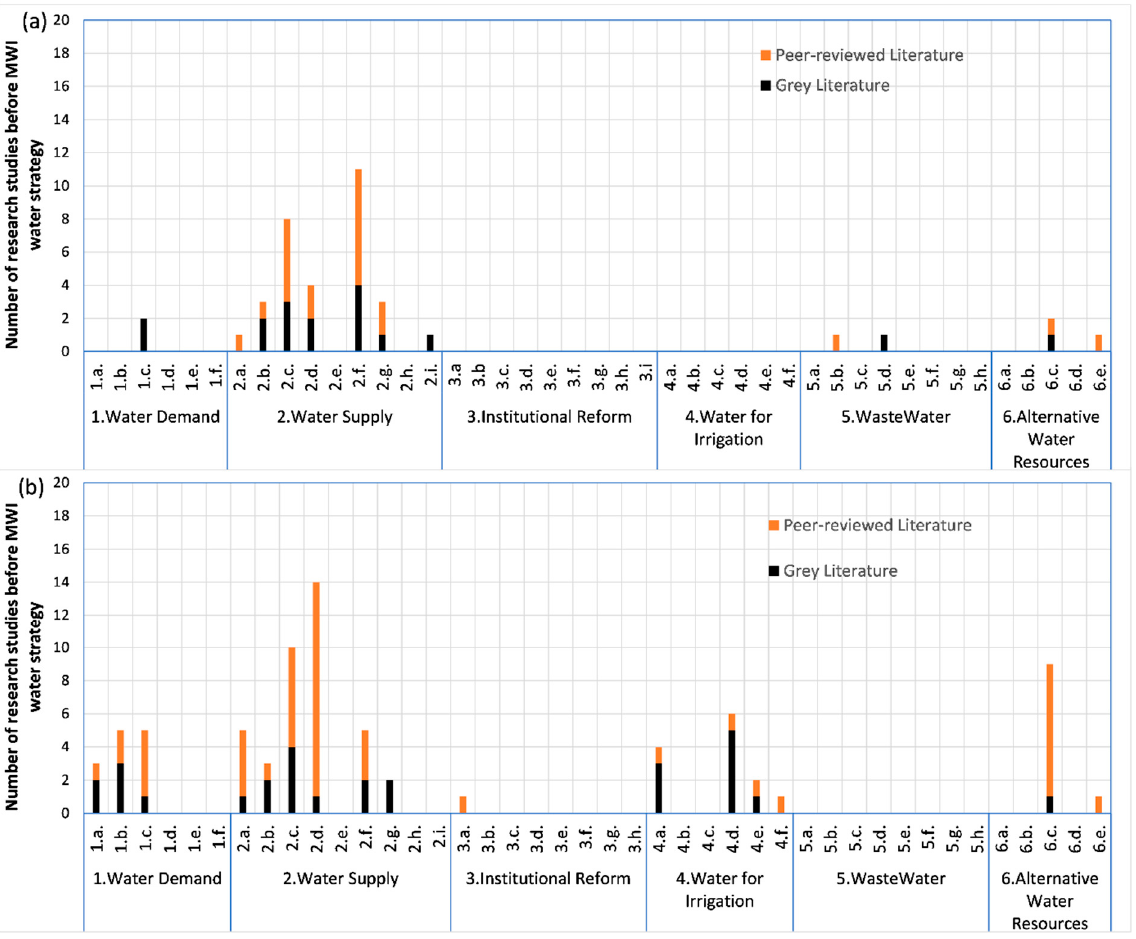
Figure 6. Number of grey and peer-reviewed studies that align with MWI water strategy goal 2008–2022 ( a ) before and ( b ) after the water strategy.